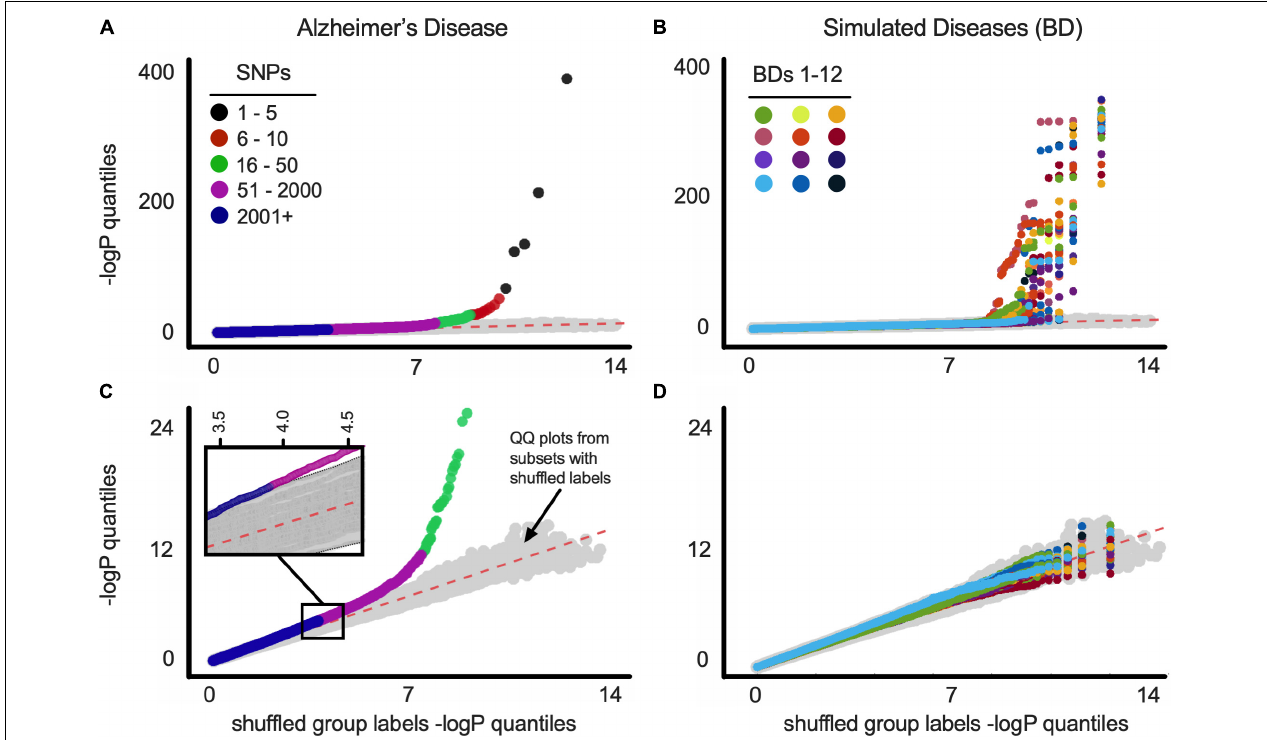
FIGURE 1 | (A) Q-Q plots of balanced ADSP dataset for Alzheimer’s disease. Gray symbols (here and below) represent Q-Q plot of 100 random versus random distributions (i.e., chance). See text for details. SNP order [based on − log(P)] is indicated by colors (see legend). (B) Q-Q plots of balanced ADSP dataset for 12 constructed (simulated) diseases (BDs). Each BD is represented by a different color. (C) Same as above with SNPs from APOE-residing chromosome 19 removed before p -value quantiles were computed. Inset is a blow up of the indicated region, showing magenta SNPs fall outside the 100 random versus random distributions (gray symbols). SNP order [based on − log(P)] is indicated by colors (see legend). (D) Same as above with SNPs from BDgene-residing chromosome removed before p -value quantiles were computed. Plot as in B is shown for all BD1-33 in Supplementary Figure 12 .